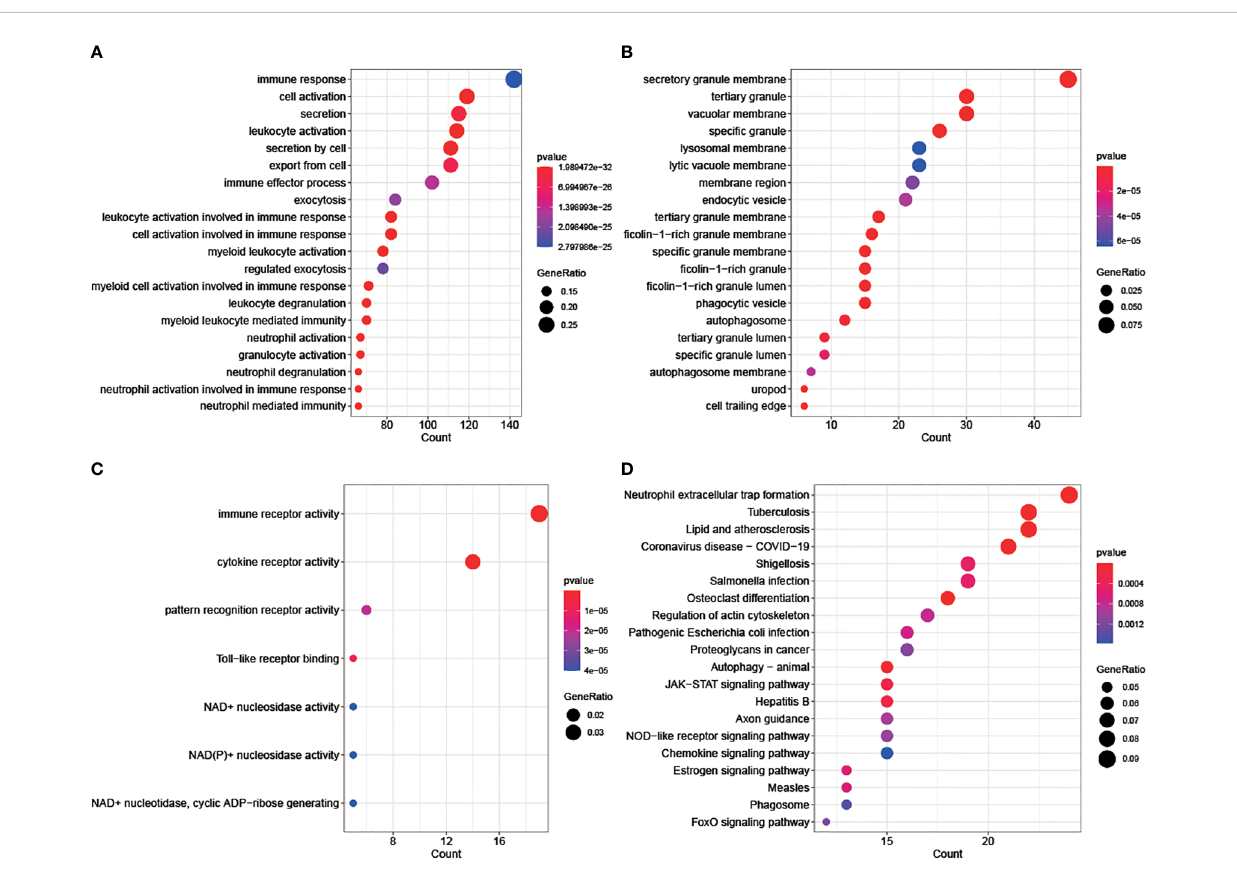
FIGURE 3 Bubble diagrams displaying the top 20 signi fi cant enrichment terms for the ISOSGS. (A) BP terms; (B) CC terms; (C) MF terms; (D) KEGG